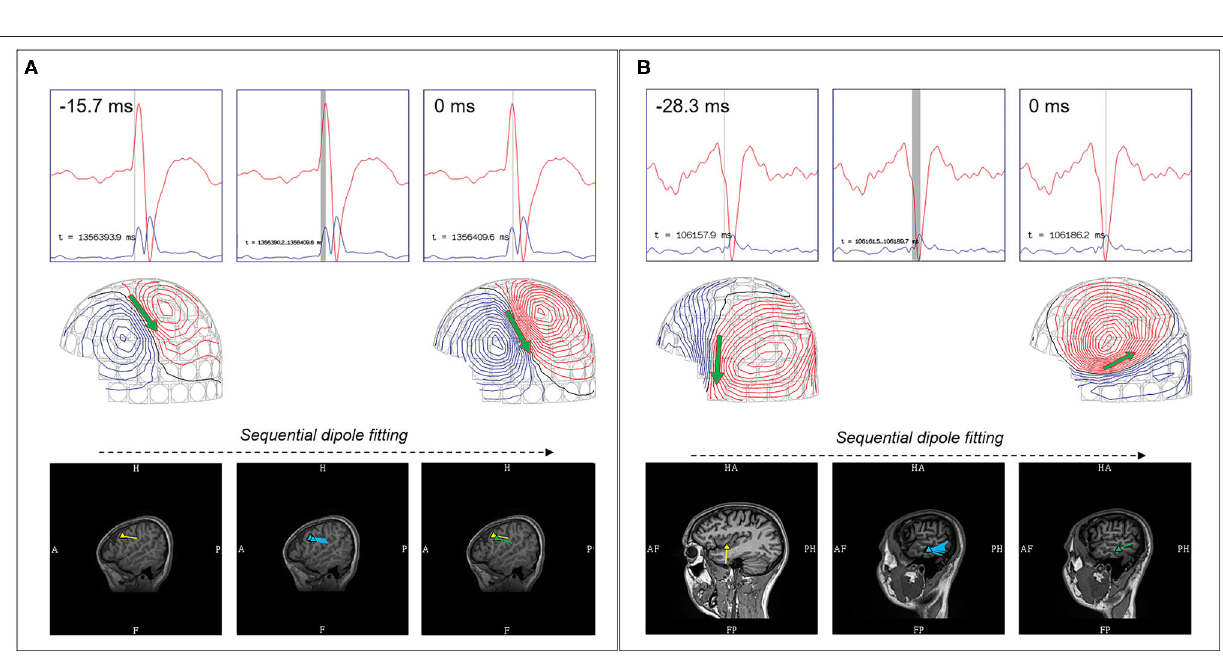
FIGURE 4 | Comparison between stable and propagating sources. (A) Stable source with earliest localizing dipole (yellow), sequential dipoles (blue), and dipole at MEG peak (green), showed similar sublobar localization. (B) Propagating sources showed earliest localizing dipole (yellow) over the left mid-superior temporal gyrus, but sequential dipoles (blue) and dipole at MEG peak (green) showed propagation to the posterior middle temporal